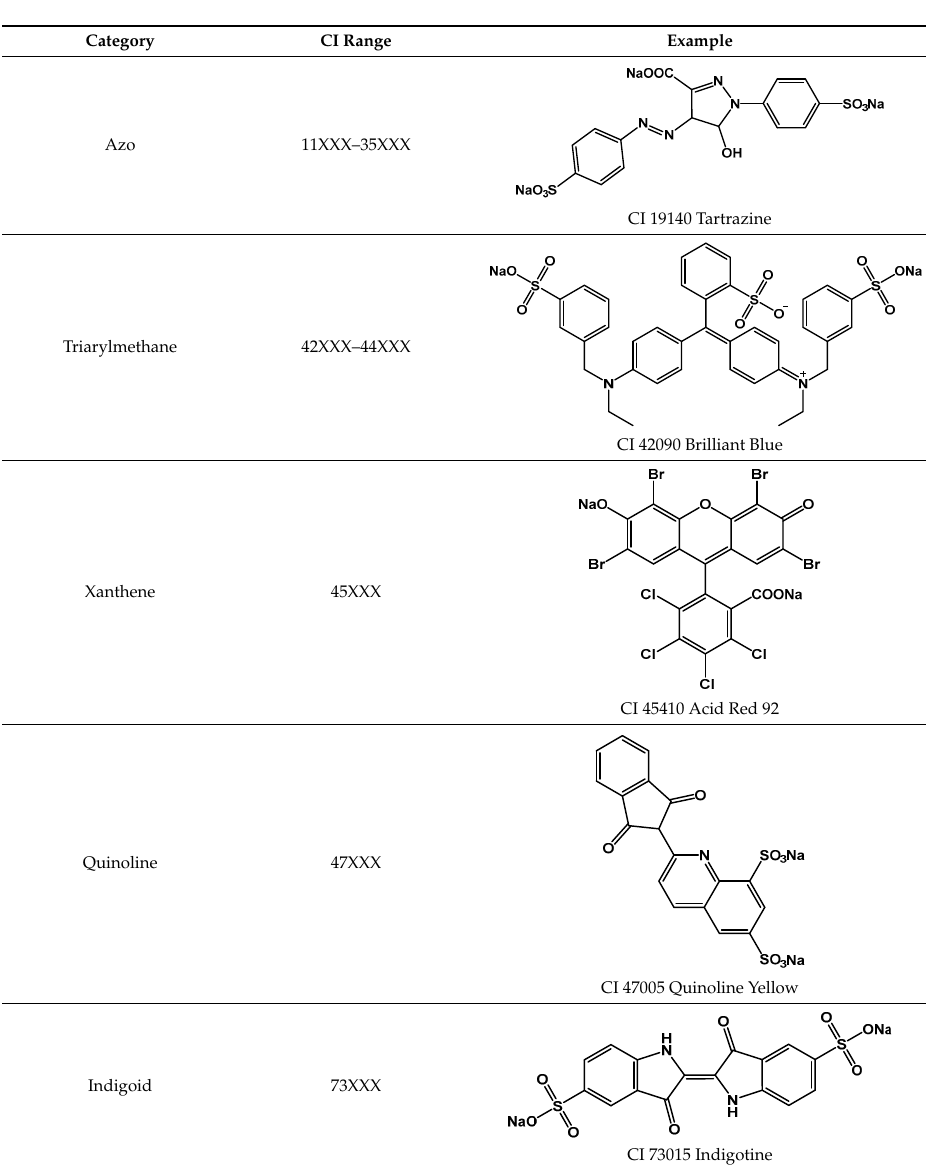
Table 1. Classification of dyes according to their chemical structure.